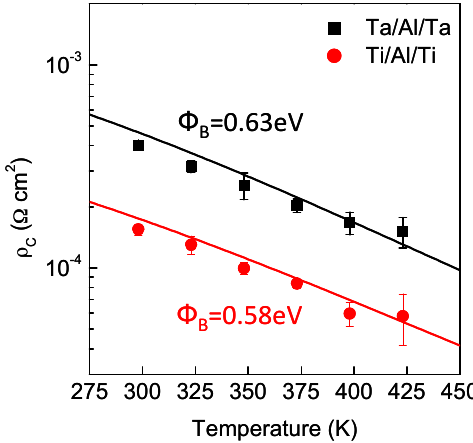
Figure 7. Temperature dependence of specific contact resistance ρ C for the Ta/Al/Ta (squares) and Ti/Al/Ti (circles) contacts annealed at 600 °C. The lines represent the fits of the experimental data with the thermionic field emission (TFE) model (Equation (2)).